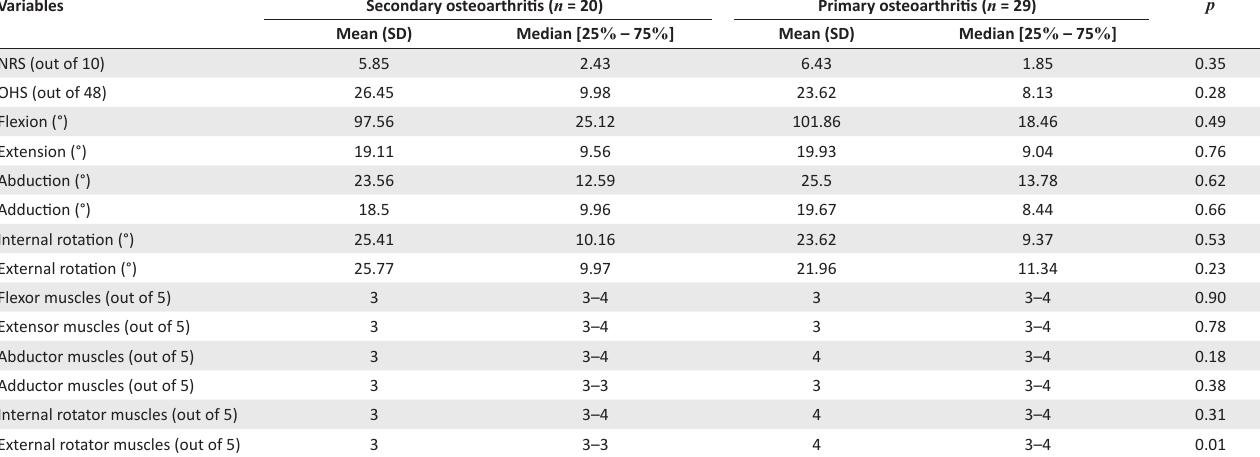
TABLE 2: Comparison of body structures and function in primary versus secondary